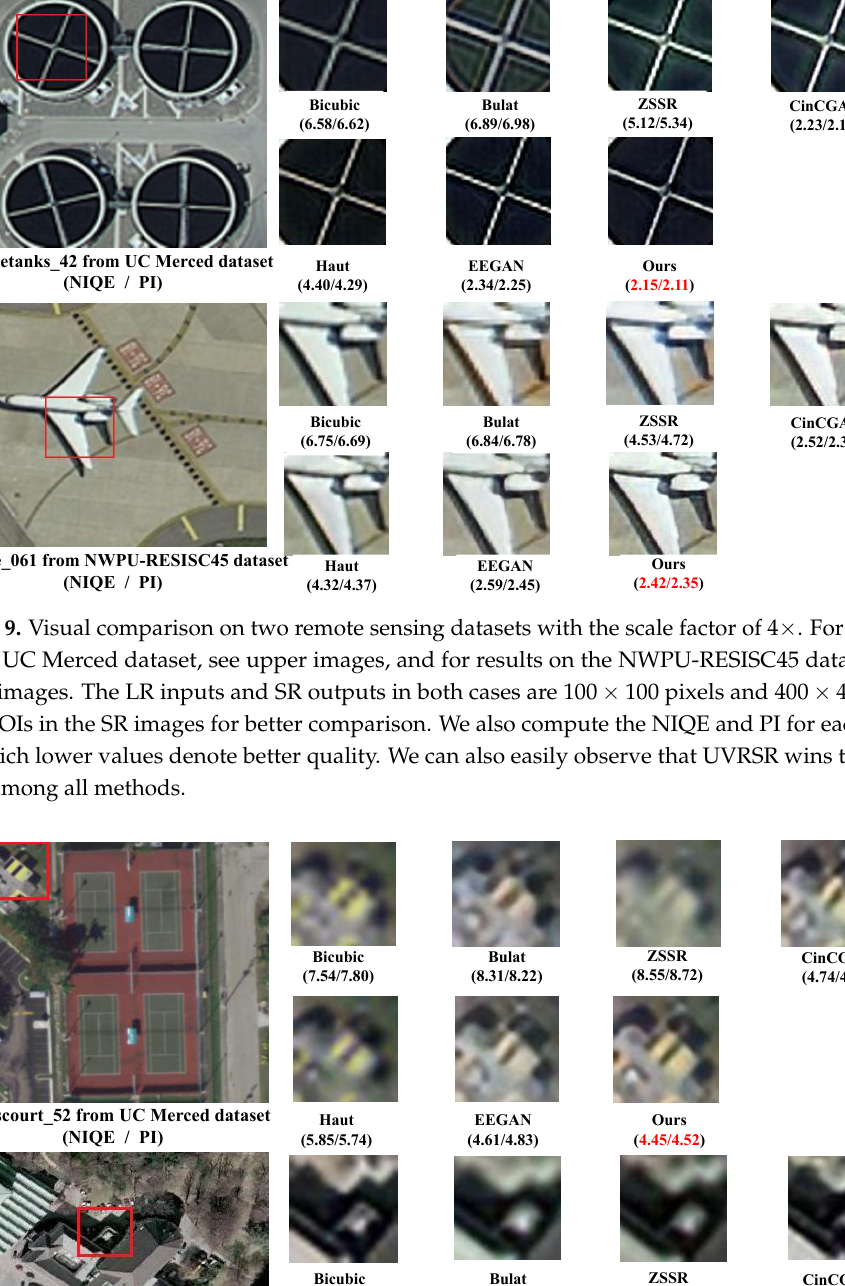
. Results Figure 10. Visual comparison on two remote sensing datasets with the scale factor of 8 × on UC Merced dataset see upper images and NWPU-RESISC45 dataset see lower images. The LR inputs and SR outputs in both cases are 80 80 pixels and 640 640. We crop ROIs in the SR images for better comparison. Also we compute the NIQE and PI for each ROI which lower denote better quality. We can conclude that UVRSR yields the performance among all methods.